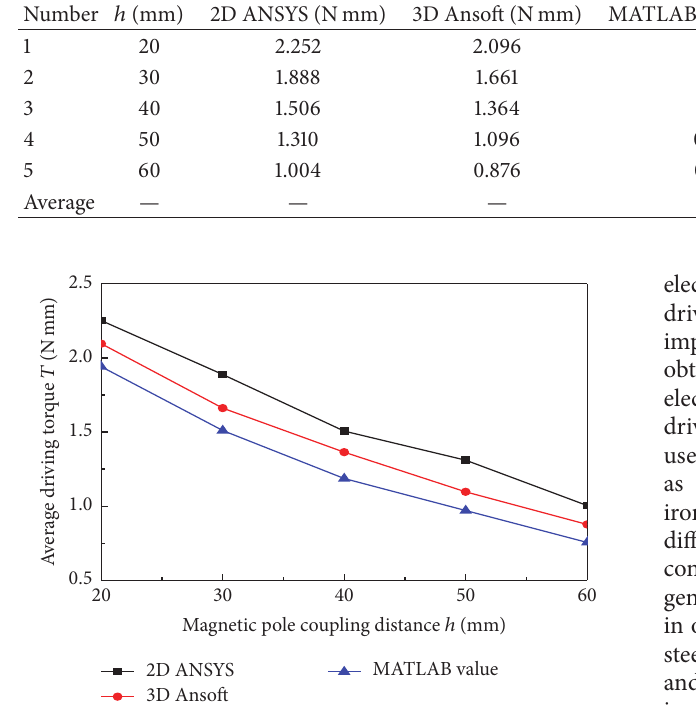
Figure 7: Theory and simulation results comparison of average driving